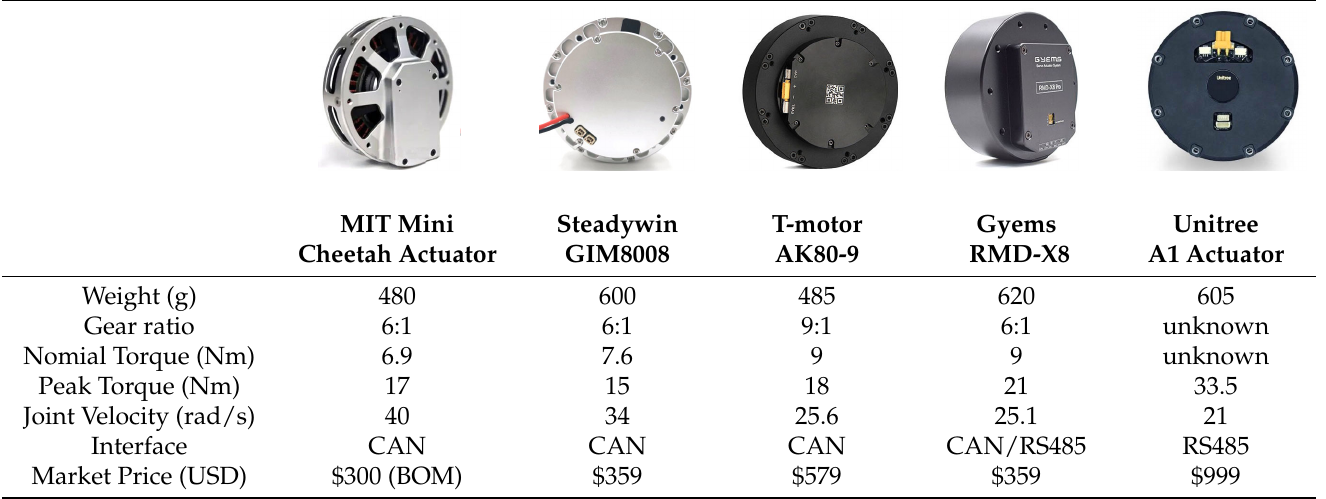
Table 1. Comparison of modular quasi-direct drive